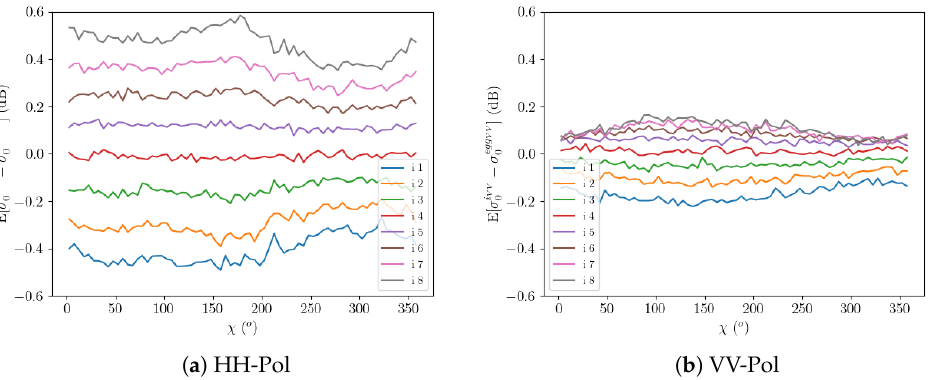
( σ VV − Pol ) bias with respect to σ 0, egg as a function of the azimuth angle Figure 9. Left (right): σ HH − Pol 0 0 in the open ocean, evaluated over all the orbits dated 10 April 2007 . In the y-axis label, HH (VV) stands for HH-Pol (VV-Pol) and i in the legend represents the slice